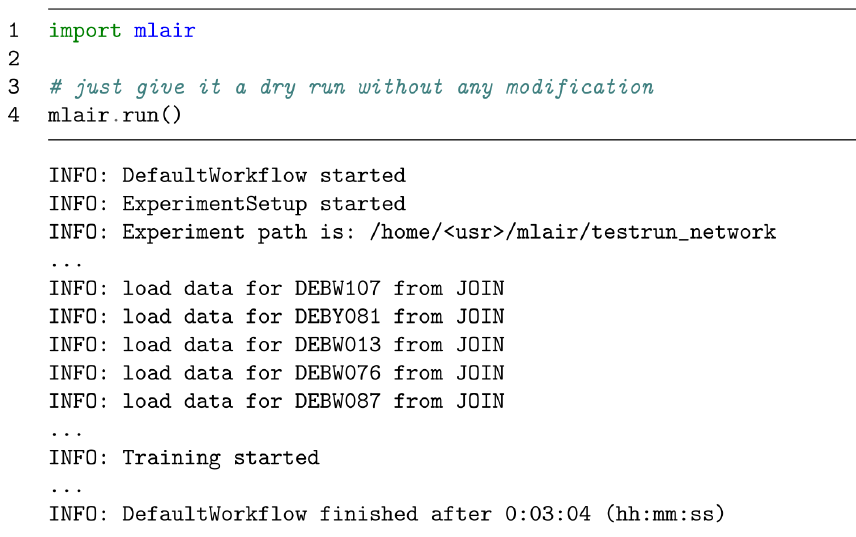
Figure 2. A very simple Python script (e.g. written in a Jupyter Notebook (Kluyver et al., 2016) or Python file) calling the MLAir package without any modification. Selected parts of the corresponding logging of the running code are shown underneath. Results of this and following code snippets have to be seen as a pure demonstration, because the default neural network is very simple.